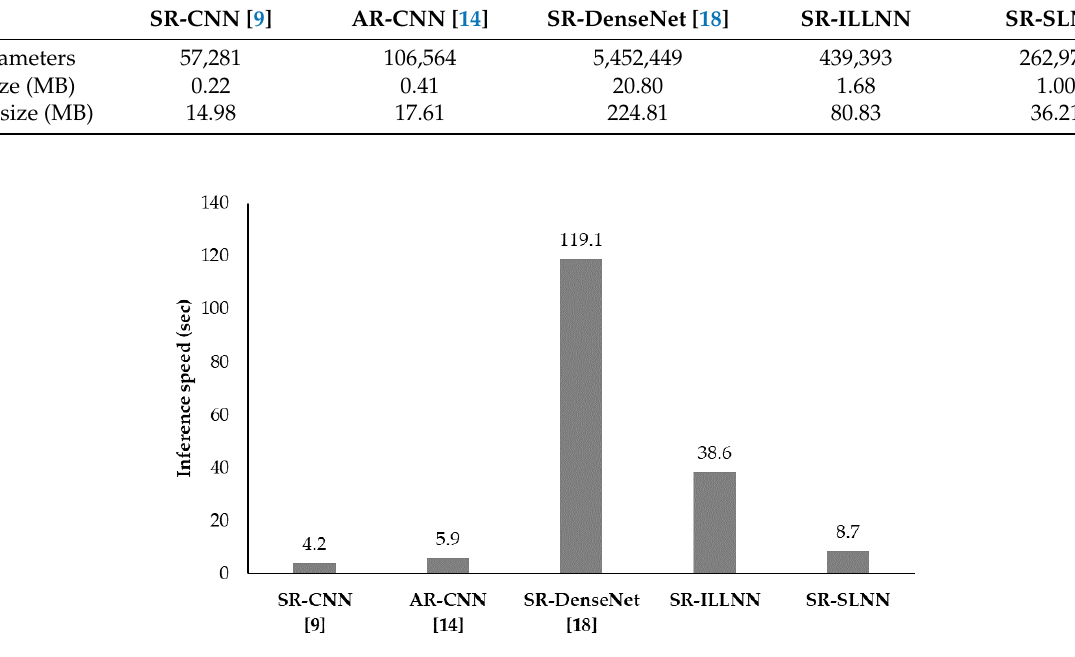
Table 9. Analysis of the number of parameters and memory size.